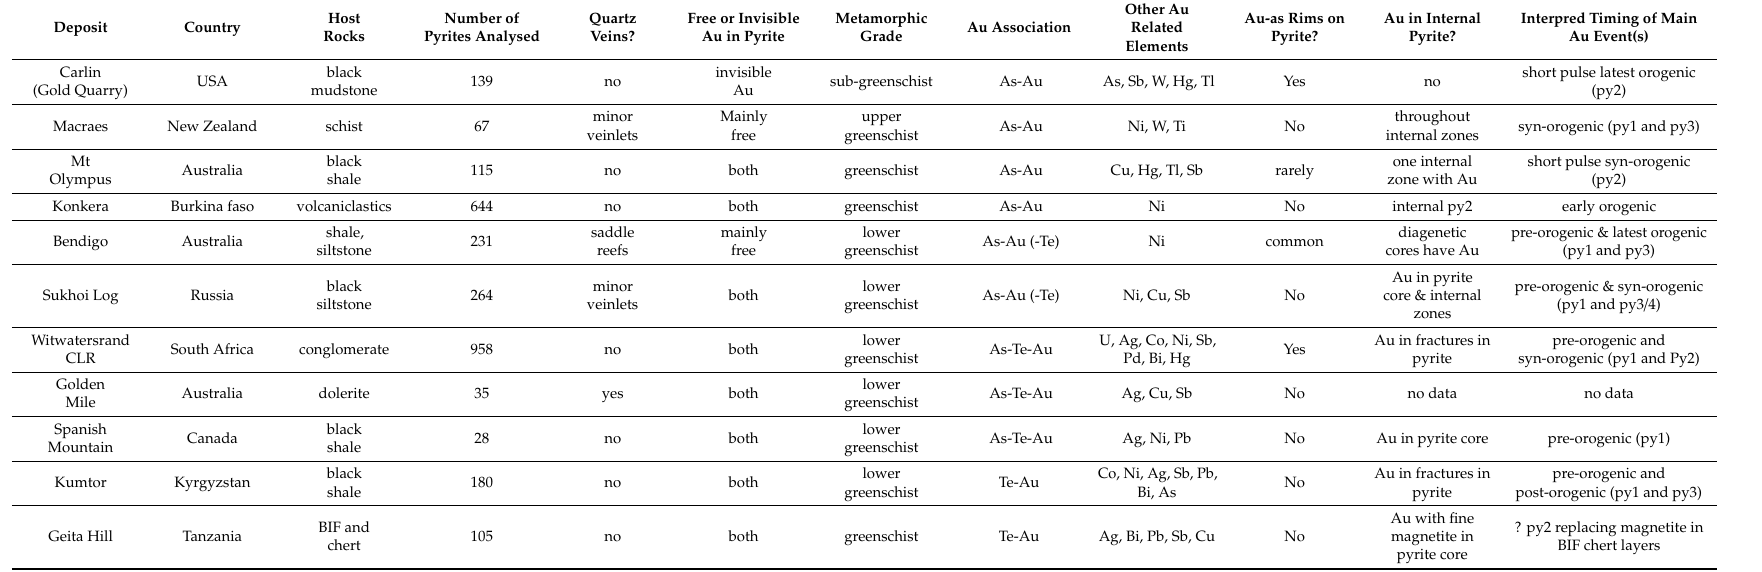
Table 1. Some features of the Au deposits in this